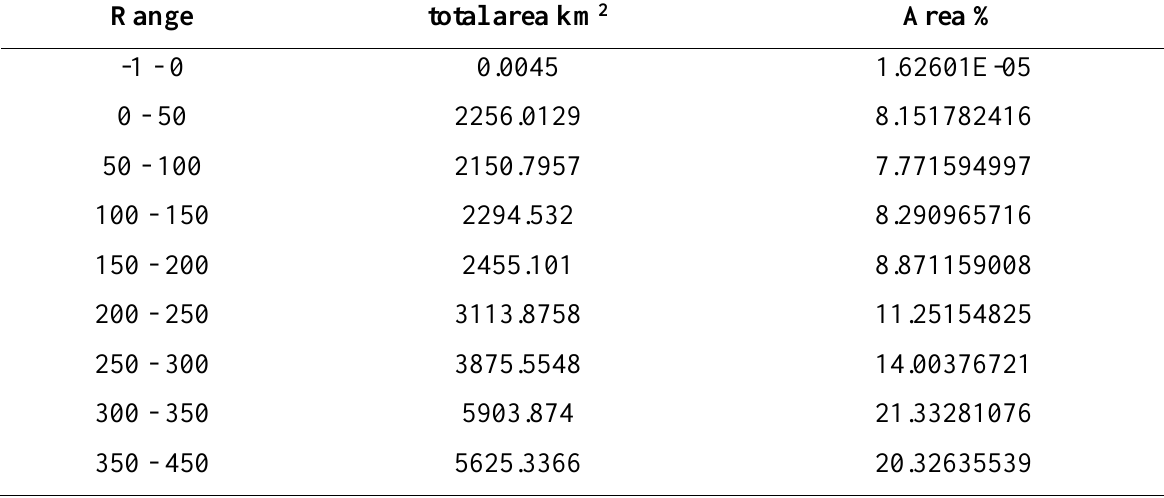
Table 1. The ranges of each classification of DEM .